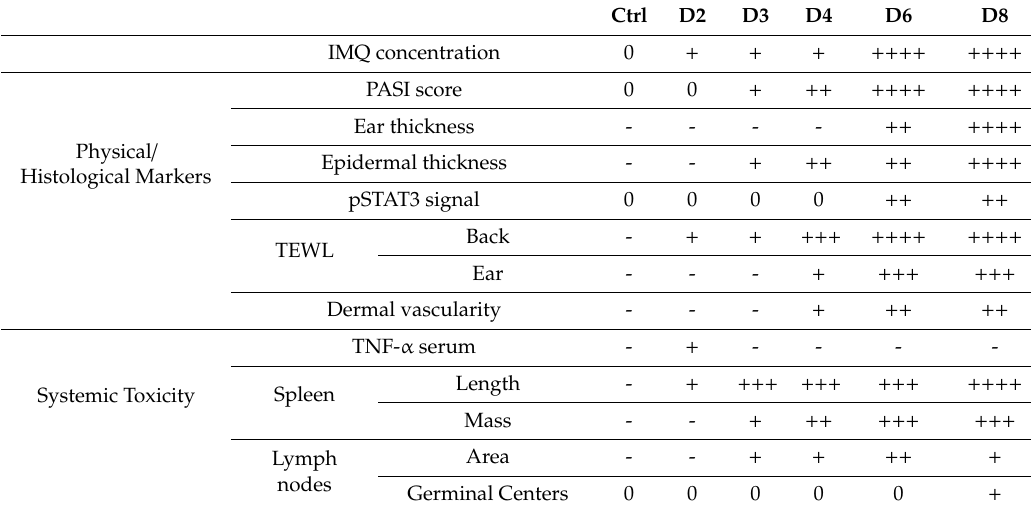
Table 1. Evolution of identified psoriatic parameters following the eight days of IMQ topical application (0: absence of parameter; -: basal level of the parameter; +/++/+++/++++ : presence of the parameter with higher intensity than basal state, from + for weak increase until ++++ for high